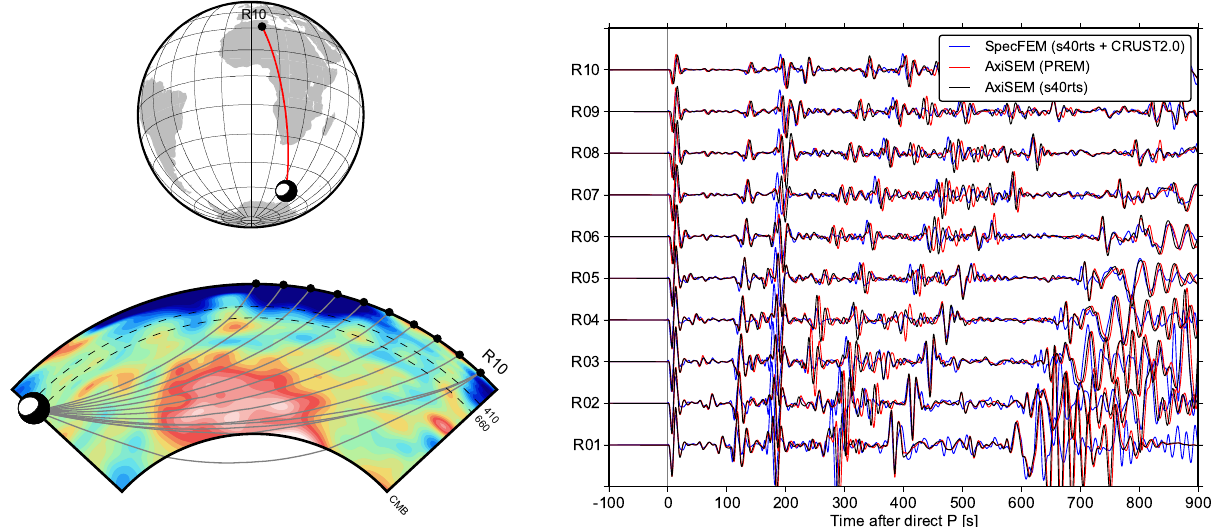
Figure 15. Modeling 3-D wave propagation through a 2.5-D version of tomographic model S40RTS (Ritsema et al., 2011) (bottom left) for an event near Antarctica (left top). Right: Seismograms filtered at 10s from the receivers denoted in the cross section (bottom left) for the 1-D model, the 2.5-D tomographic model, and SPECFEM synthetics through S40RTS and CRUST2.0 (Bassin et al., 2000), aligned with the P -wave arrival time.